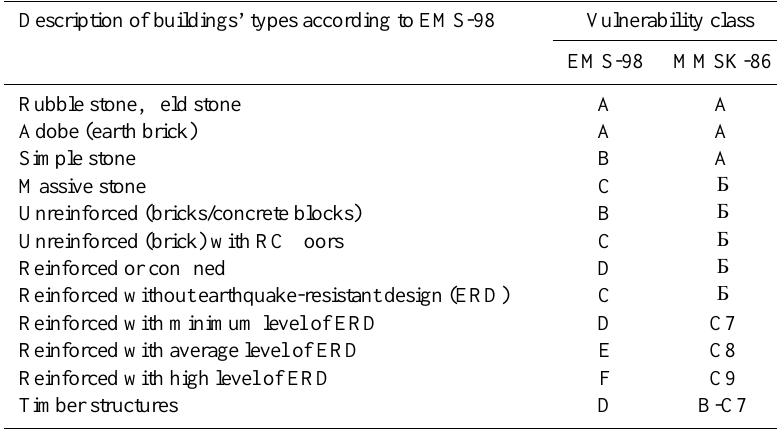
Table 1. Comparison of building vulnerability classes according to MMSK-86 and EMS-98.